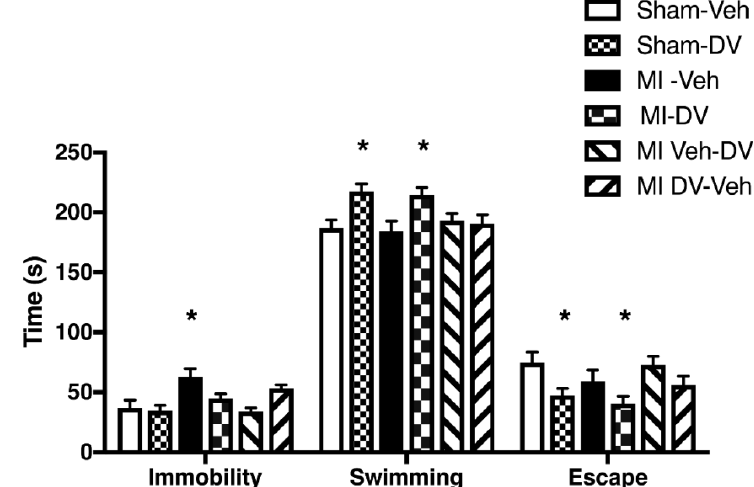
Figure 3. Forced swimming test. MI rats treated with the vehicle were more immobile than the Sham rats treated with the vehicle and they swam less than the Sham rats treated with the vehicle or with DV. MI rats treated with DV performed at the same level as sham rats treated with the vehicle or with DV on measures of immobility and swimming. Escape trial duration was significantly longer in MI rats treated with the vehicle than the DV-treated Sham rats and MI rats. n = 9–12 per group. * p < 0.05. MI: myocardial infarction; Veh: vehicle; DV: Desvenlafaxine.